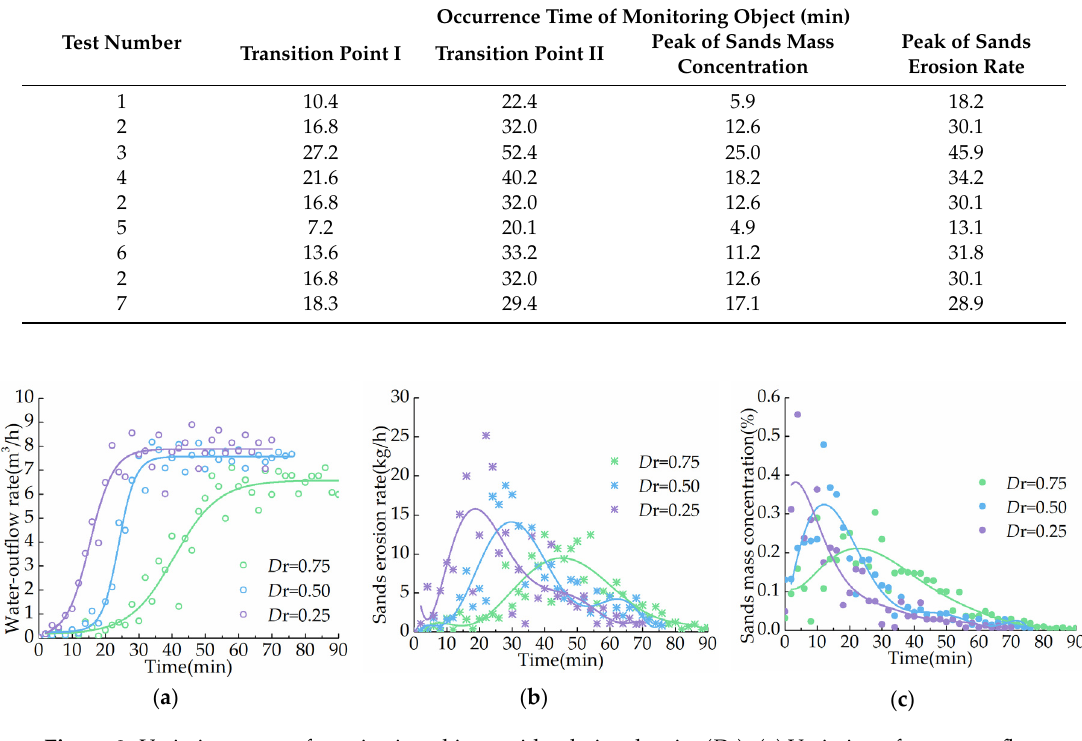
Figure 9. Variation curve of monitoring objects with relative density ( D r ). ( a ) Variation of water-outflow rate with relative density; ( b ) Variation of sands erosion rate with relative density; ( c ) Variation of sands mass concentration with relative density.